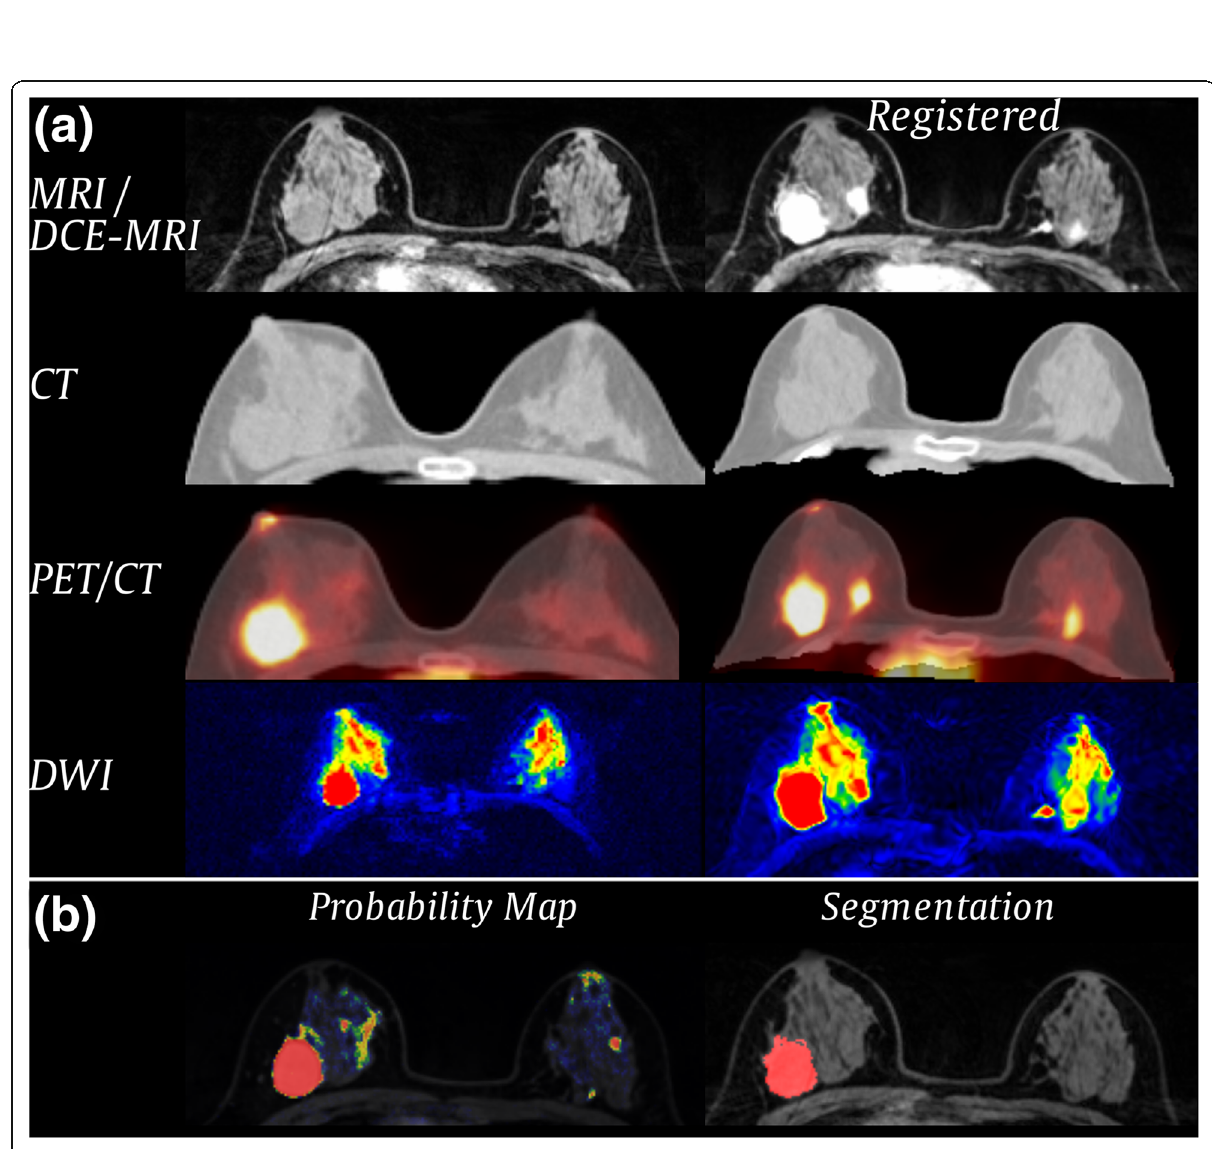
Fig. 3 Results of the ( a ) registration and ( b ) segmentation process for one patient. a First row: Reference I dce-pre and registered I dce-post . Second row: I ct unregistered/registered. Third row: I pet image unregistered/registered, fused with the corresponding CT image. Fourth row: I dwi b0 unregistered/registered. b Probability map obtained from voxel-wise classification overlaid on the MR pre-contrast image (left) and final segmentation after applying a threshold and post-processing (right)